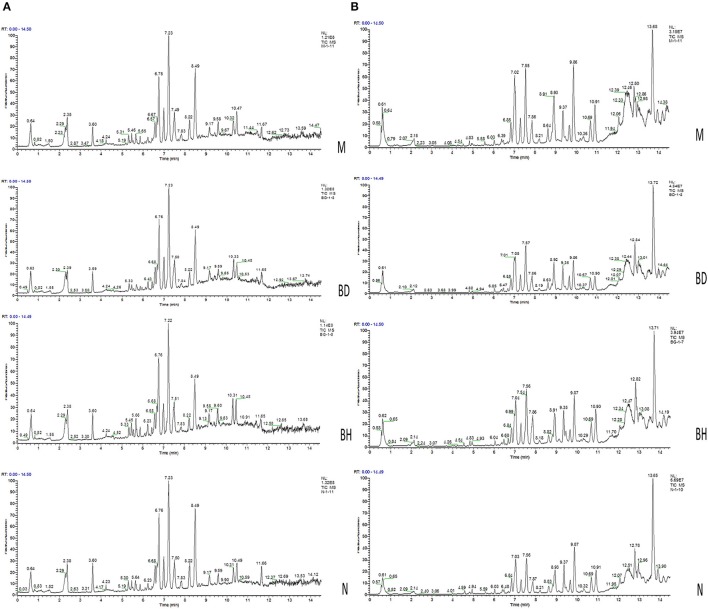
Analysis of the metabolic profiles based on the UPLC/MS spectra of serum samples. Serum BPI chromatograms of APP/PS1 and wild-type mice collected in positive ion mode (A) and negative ion mode (B). N denotes the control group, M represents the APP/PS1 transgenic group, BD denotes the 50 mg/kg OMO-treated group, and BH designates the 100 mg/kg OMO-treated group.